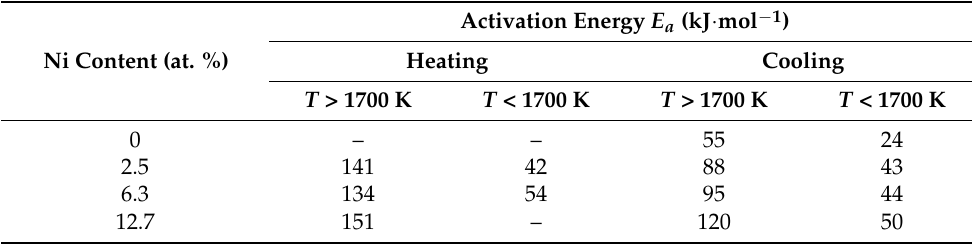
for linear sections of Arrhenius plots.